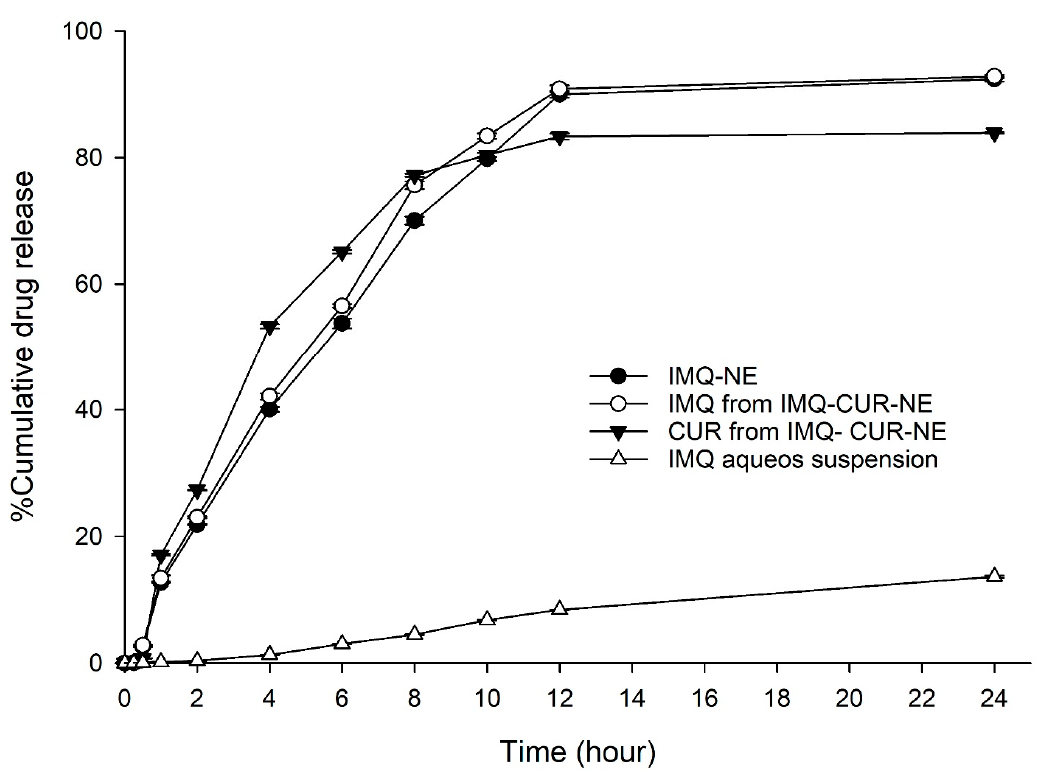
Figure 5. In vitro drug release profile of IMQ from different formulation (IMQ-NE, IMQ-curcumin (CUR)-NE) and CUR from IMQ-CUR-NE in comparison to aqueous suspension of IMQ. The different kinetic models, such as zero order, first order, Higuchi, and Korsmeyer–Peppas were applied to predict the release kinetics and the diffusion behavior of IMQ from IMQ-NE and IMQ-CUR-NE and CUR from IMQ-CUR-NE (Table 2) [23]. The best-fitting release kinetic model was indicated by the value of the correlation coefficient (r 2 ) (Table 2). Overall, the best curve fitting representing the IMQ and CUR release from the respective NE formulation followed the Korsmeyer– Peppas model (highest value of r 2 ) with Fickian diffusion ( n < 0.45), as shown in Table 2. This indicates the minimal possible interaction between the drug molecules and NE components [38]. Table 2. In vitro drug release kinetics of IMQ and CUR from NE formulations. Korsmeyer-Peppas Zero- First- Higuchi Figure Model Order Order